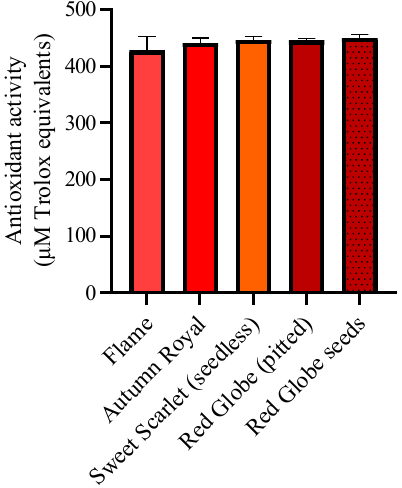
Figure 3. The antioxidant activity of the four grape varieties, Flame, Autumn Royal, Sweet Scarlet (seedless), Red Globe (pitted) and seeds. All the tested grape varieties including their seeds showed high antioxidant activity assay without significant changes from each other. The results are expressed as SE ± (n = 3).